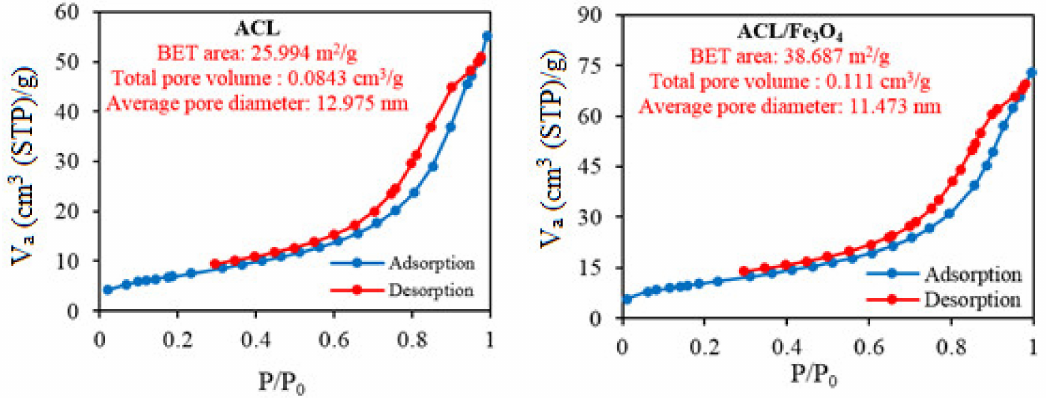
Figure 2. Nitrogen adsorption-desorption analysis for ACL and ACL/Fe 3 O 4 magnetic nanocomposite